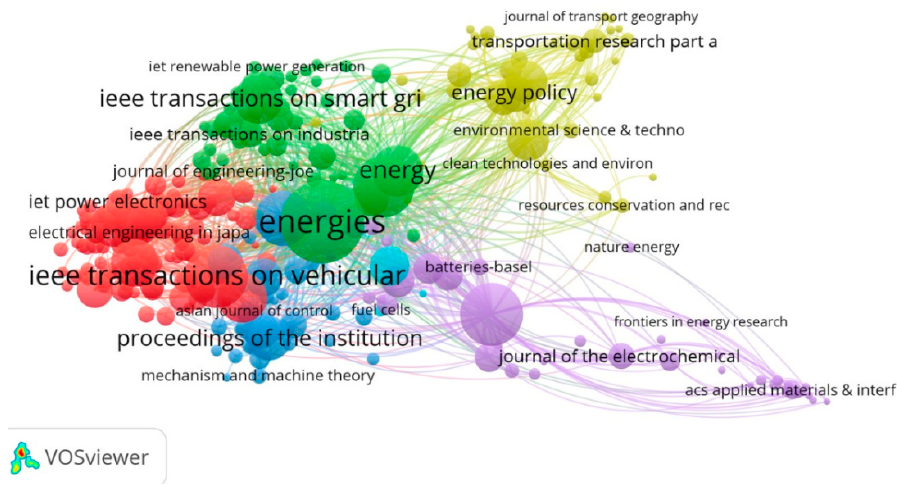
Figure 6. Network visualization of the journals based on total link strength.